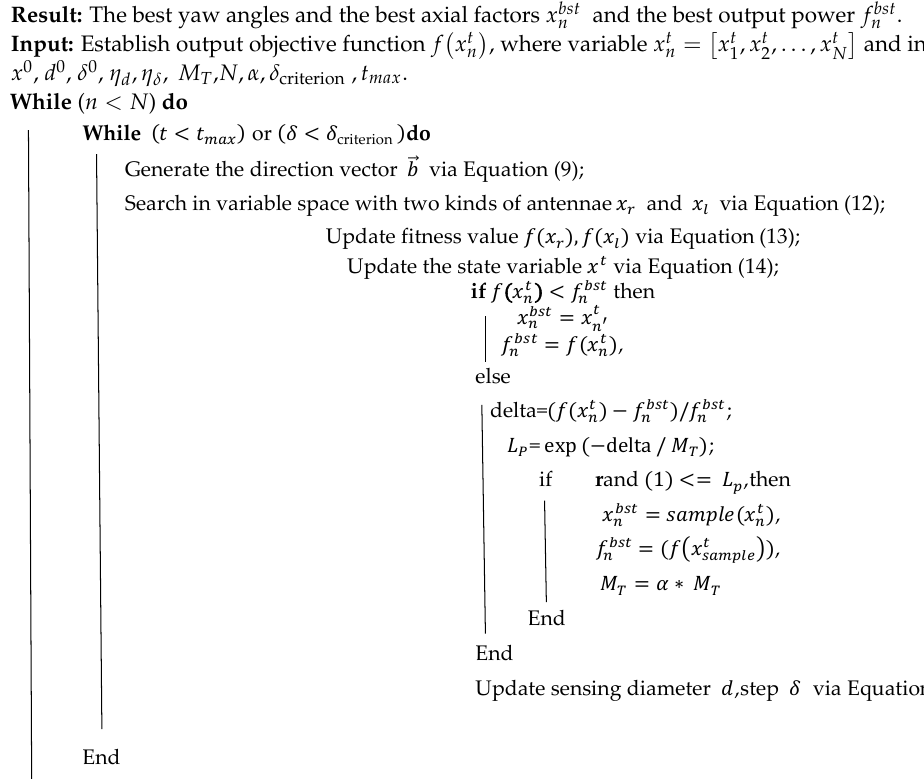
Algorithm 2 : The grouped MC-BAS methodology for wind farm power production (MC-BAS Algorithm) Result: The best yaw angles and the best axial factors x bst n and the best output power f bst n .